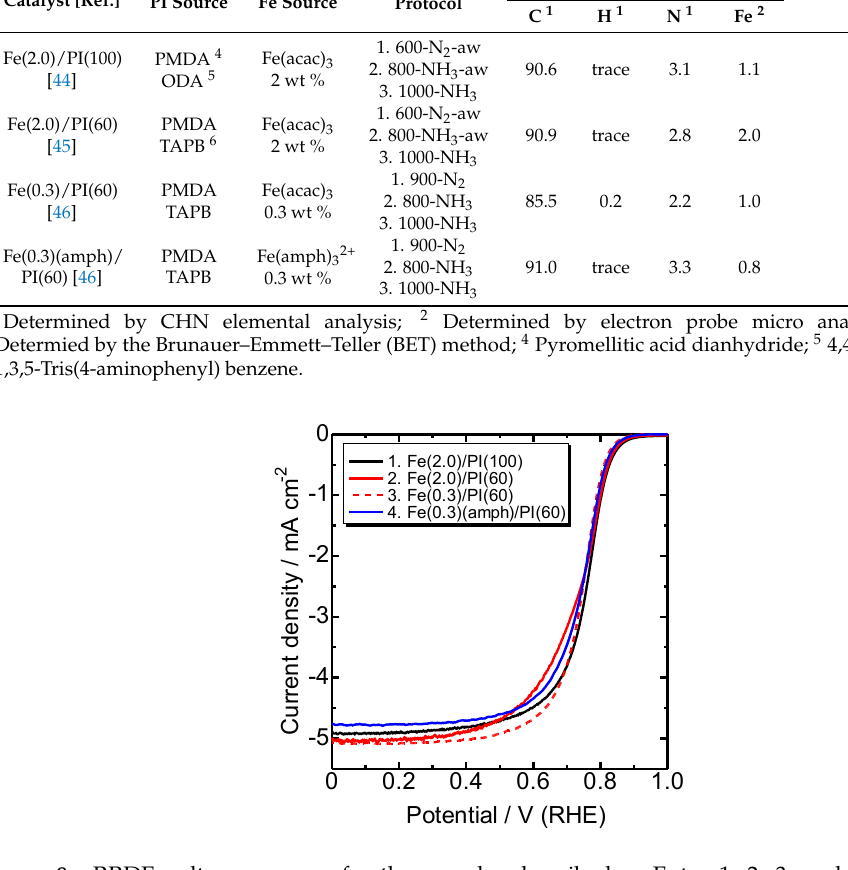
Figure 8. RRDE voltammograms for the samples described as Entry 1, 2, 3, and 4 in Table 1. The